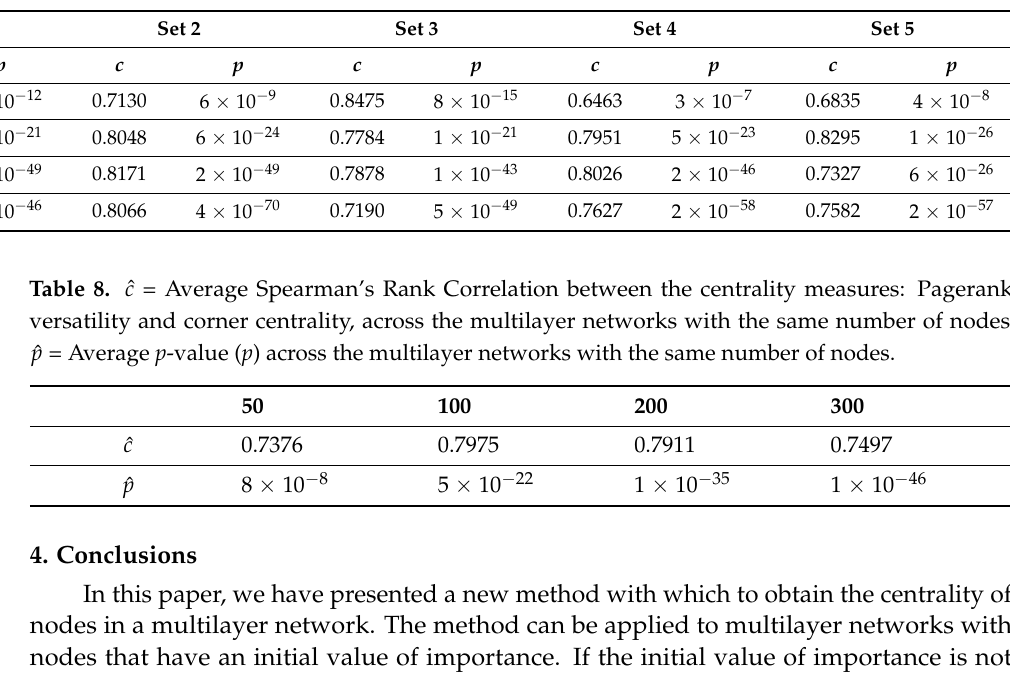
Table 7. Spearman’s Rank Correlation between the centrality measures of the Pagerank versatility and corner centrality ( c ) and p -value ( p ).